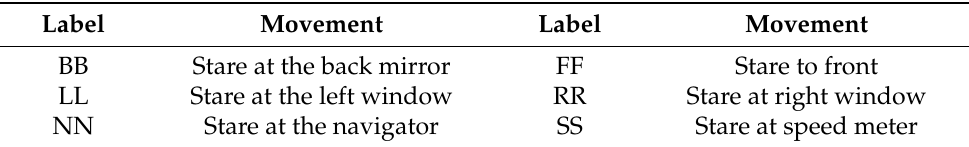
Table 1. Labels included in our network. Each label represents a head direction towards one of the six standard driving gaze